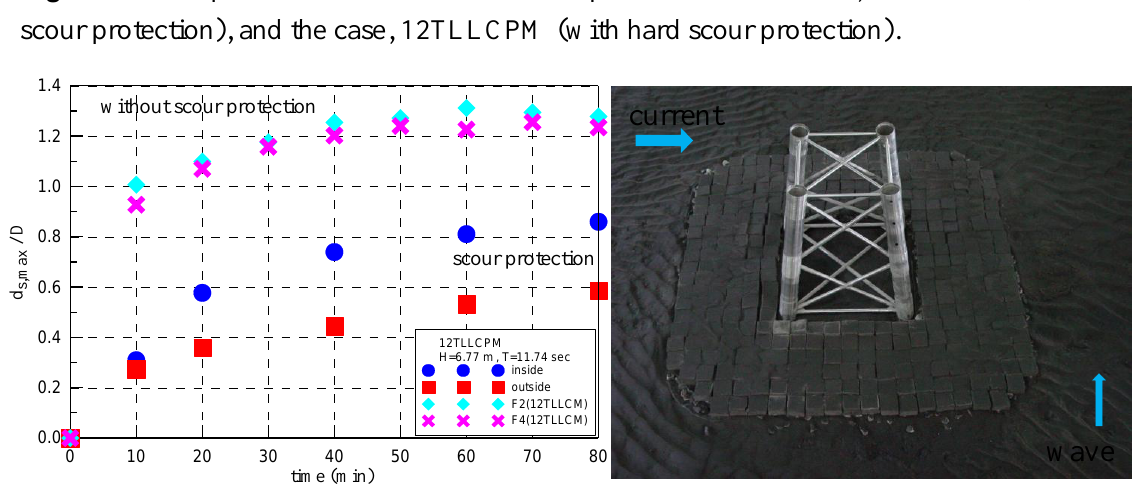
Figure 8. The potential impact erosion areas around the hard scour protection for the jacket-type foundation under the case,